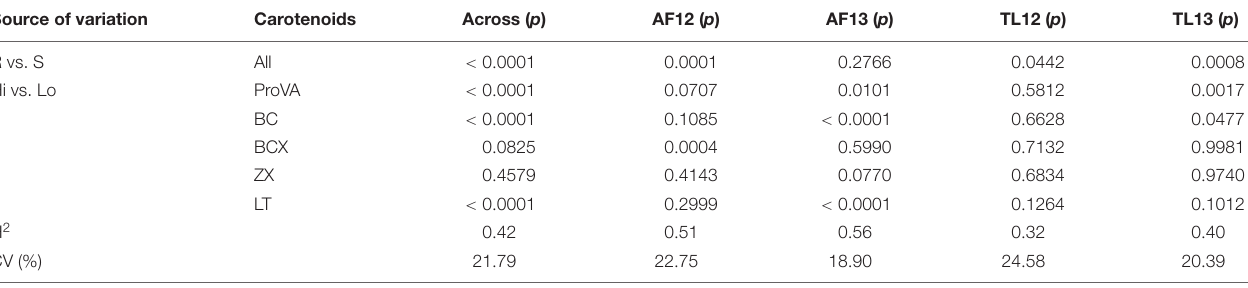
TABLE 3 | Probabilities of significance ( p ) for F -tests for contrasts of hybrids of aflatoxin resistant (R) vs. susceptible (S) testers, and for hybrids with high (Hi) vs. low (Lo) carotenoids concentrations for A. flavus ear rot symptom scores [pERt, sqrt(pER)] for analyses of variance at individual and across five trial environments. Source of variation